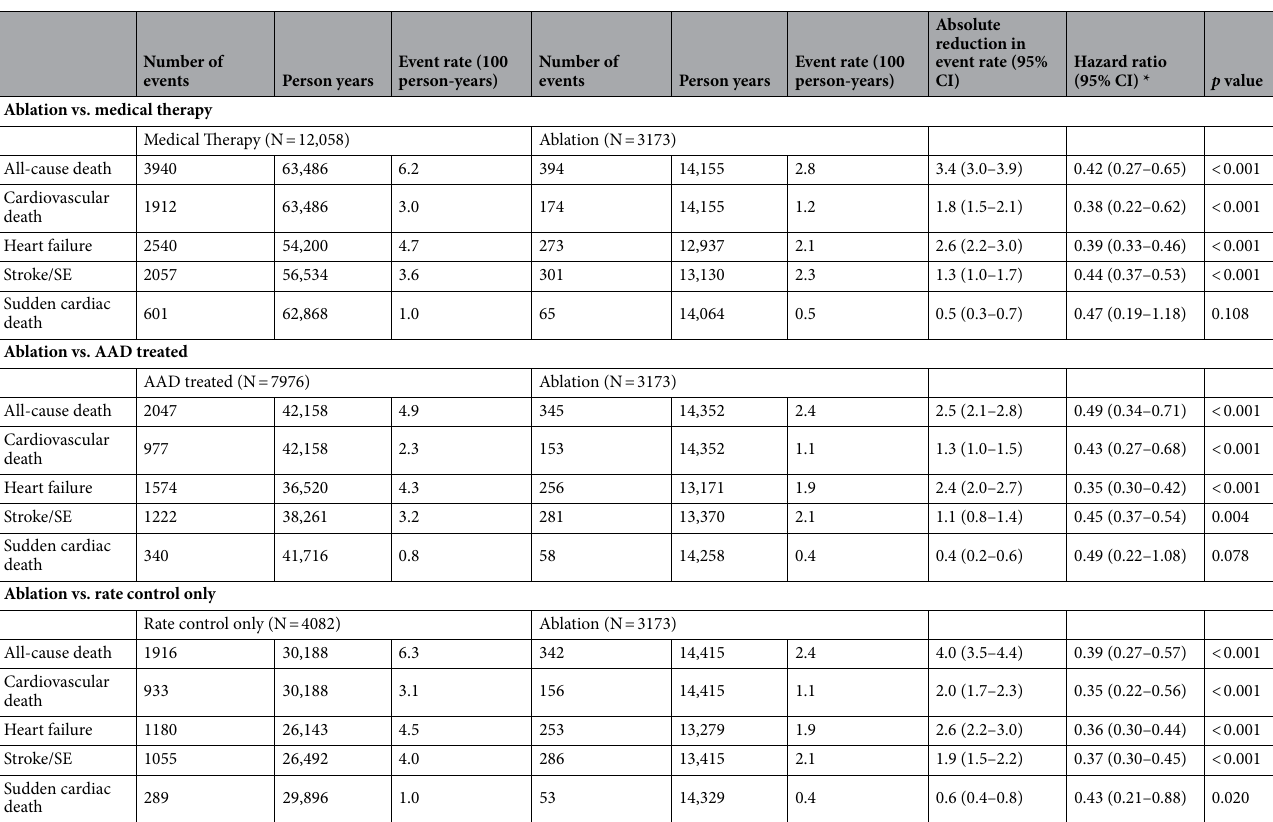
Table 2. Risk of clinical outcomes in propensity score-weighted patients stratified by treatment. *Adjusted for age, sex, income, AF duration, CHA 2 DS 2 -VASc score, modified HAS-BLED score, hospital frailty risk score, Charlson comorbidity index, hypertension, diabetes, ischemic stroke/TIA, myocardial infarction, peripheral arterial disease, hypertrophic cardiomyopathy, chronic kidney disease, end stage renal disease, liver disease, malignancy, hyperthyroidism, hypothyroidism, venous thromboembolism, COPD, intracranial bleeding, previous cardioversion, history of bleeding, baseline use of warfarin, non-vitamin K antagonist oral anticoagulant, aspirin, clopidogrel, beta-blocker, ACE-inhibitor/ARB, dihydropyridine/nondihydropyridine CCB, statin, diuretics, digoxin, and OAC coverage rate of time at risk. AAD antiarrhythmic drug, CI confidence interval, SE systemic embolism. Other abbreviations are same as Table